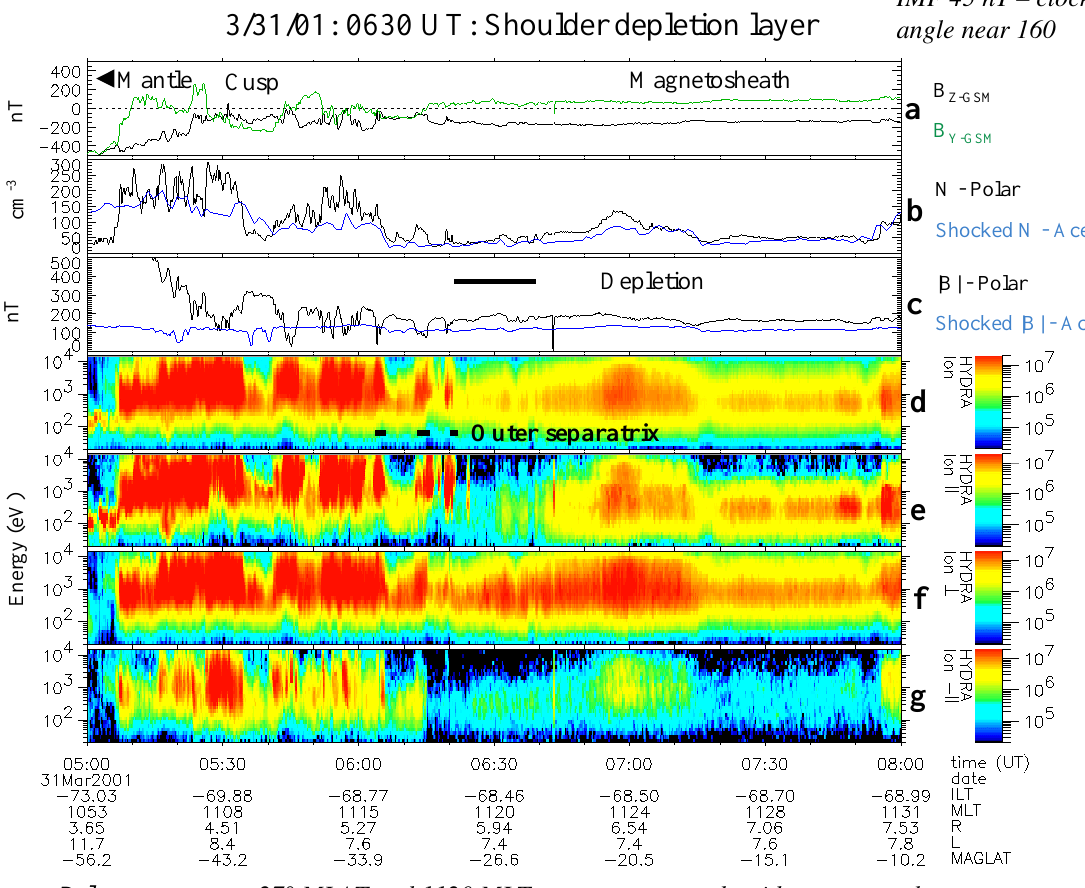
Fig. 9. Polar data from 31 March 2001, showing a shoulder depletion layer located below the Southern Hemisphere cusp in the same format as Fig. 1. Because of the strong driving conditions Polar crossed from the mantle into the magnetosheath, not contacting the dayside magnetosphere. In this case the dipole is tilted away from the